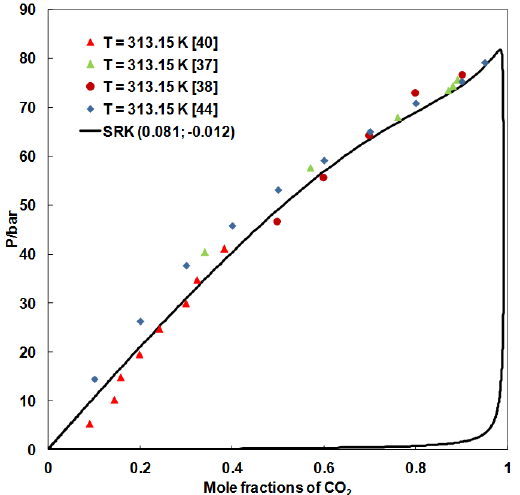
Figure 3. Comparison of literature data for the carbon dioxide Figure 5. Comparison of literature data for the carbon dioxide + 2-methyl-2-propanol ( tert -butanol) system and + 2-methyl-2-propanol ( tert -butanol) system and calculations + 2-methyl-2-propanol ( tert -butanol) calculations by the carbon dioxide + 2-methyl- system and calculations by SRK model: symbols, 2-propanol ( tert -butanol) systemSRK model: symbols, literature data at different temperatures; by SRK model: this work and literature data at ~353.15 K; and symbols, literature data at 313.15 K; solid lines, solid calculations by SRK model: symbols, literature data lines, predictions by SRK ( k = 0.081, l = -0.012). 12 12